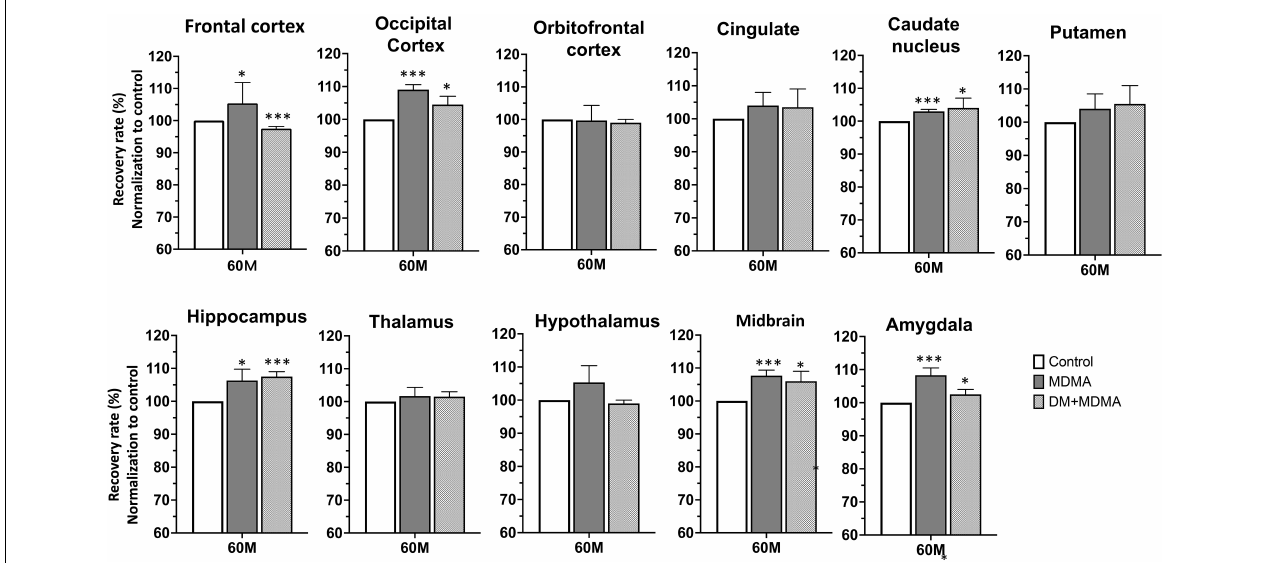
FIGURE 7 | Volumetric analysis of brain MR images. Comparison showing the volumes of the striatum, midbrain, thalamus and frontal cortex in MDMA group were significantly larger ( p < 0.01 ∼ 0.005) compared to controls. Co-administration of DM with MDMA had no significant neuroprotective effect on volumetric values. Data are presented as mean ± SEM; ∗ p < 0.05, ∗∗ p < 0.01, ∗∗∗ p < 0.005 compared to the control group.